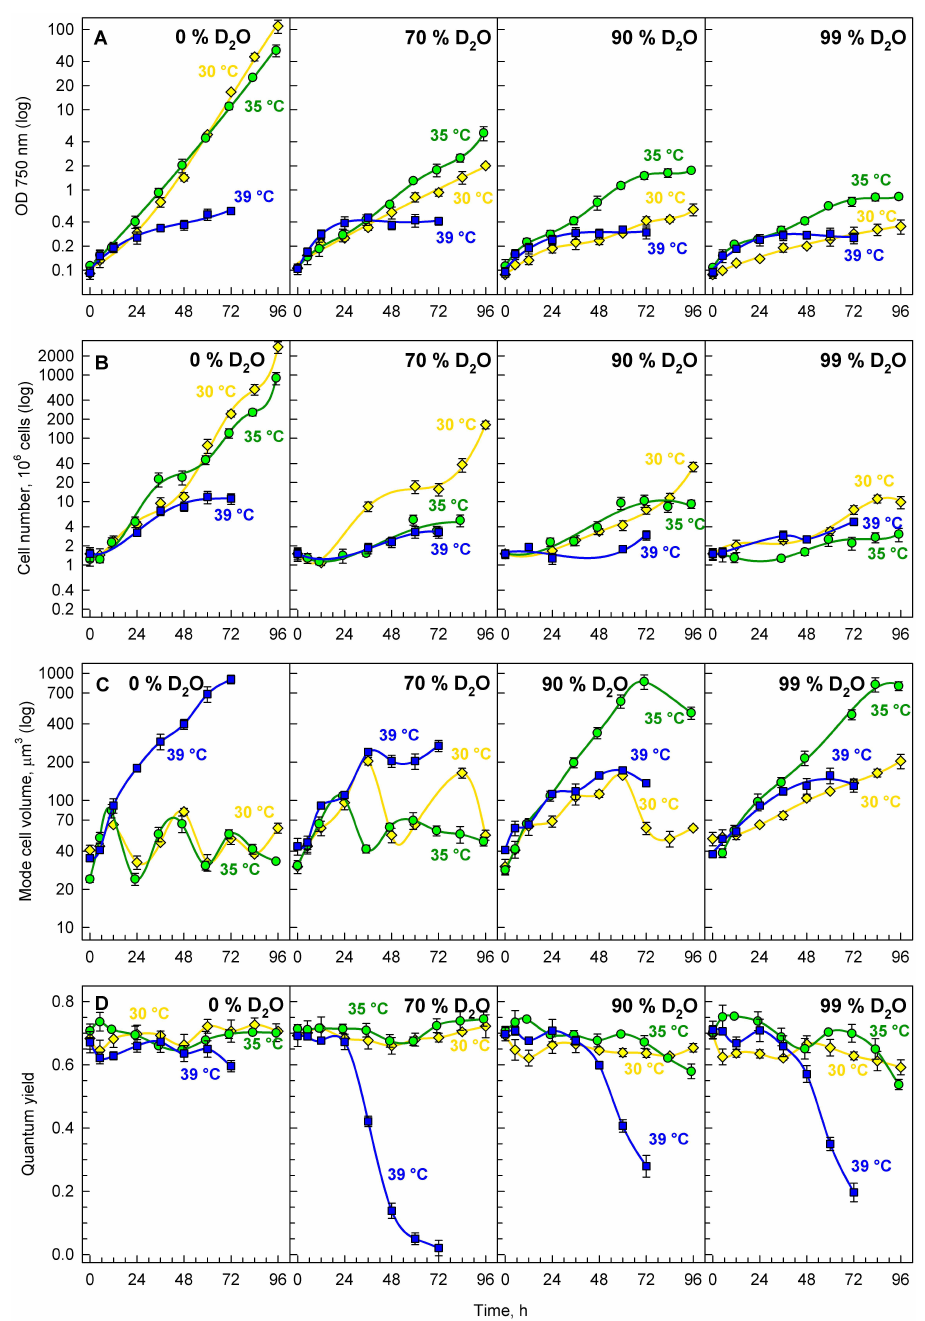
Figure 4. Time course of cell division and growth in synchronized cultures of Parachlorella kessleri grown at an incident light intensity of 110 µ mol photons m − 2 s − 1 and temperatures of 30 ◦ C (yellow diamonds), 35 ◦ C (green circles), and 39 ◦ C (blue squares), with different concentrations of deuterated water in the medium (0, 70, 90, and 99%). ( A ) Optical density at 750 nm, ( B ) cell number (10 6 mL − 1 ), ( C ) modal cell volume, and ( D ) quantum yield. Note the logarithmic scale on the Y-axis for ( A – C ). Note that the cultures were maintained in semi-batch mode. However, both panels ( A ) and ( B ) show recalculated values multiplied by individual dilution factors. Thus, they represent a projection of the growth in semi-batch cultivation mode to the continuous growth. This way, the plots remain easily